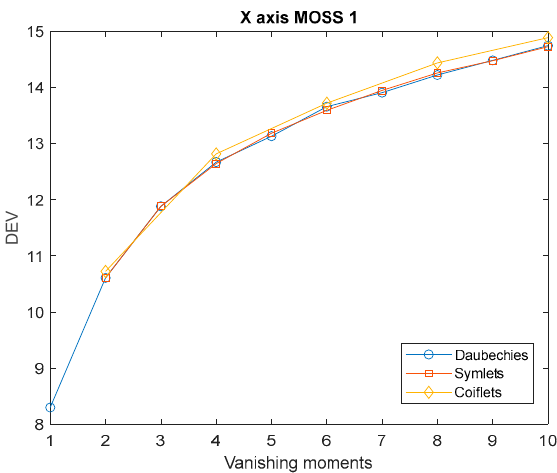
Figure 4. DEV evolution MOSS 1 on the X axis.